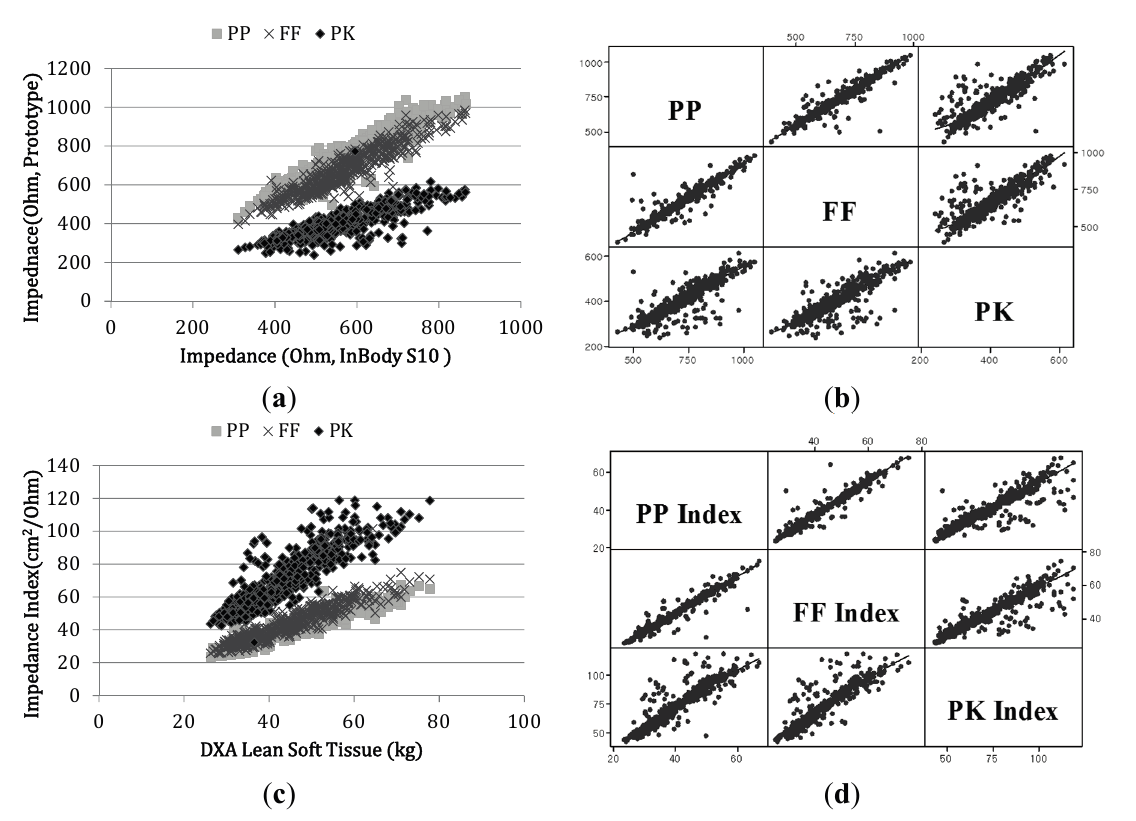
Figure 4. Scatterplots of impedance measured by reference devices vs. prototype devices. ( a ) Impedance scatter plot of the three pathways from each prototype device and the corresponding InBody pathways; ( b ) matrix plots of impedance between each pair of pathways (PP, FF and PK) from the three prototypes; ( c ) DXA LST vs. impedance index from all three prototype device pathways and ( d ) matrix plots of the impedance index between each pair of pathways (PP, FF and PK) from the three prototypes. Table 4. Coefficients of variation (CV) of multiple frequency pathways (N = 560).